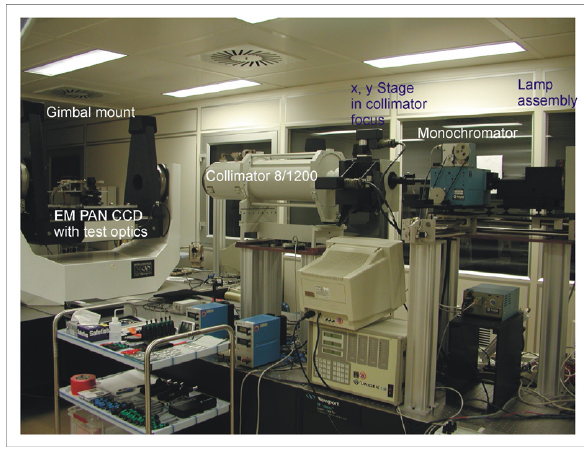
The slit target with geometric slit width of about 1 / 10 of a CCD pixel width will be located in collimator focus. The focus po- sition can be shifted by x- and y- step motors. The wavelength selection will be done by selecting a metal interference filter that is arranged between halogen lamp and collimator. Figure 3 illus- trates this set-up.